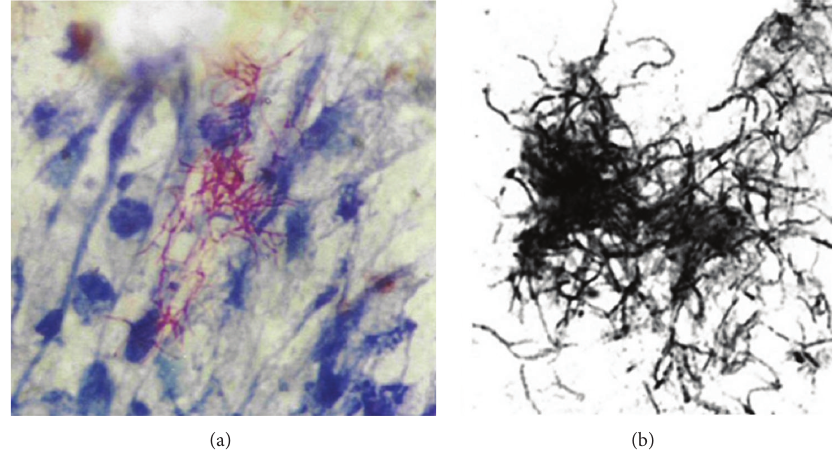
Figure 3: Smears made from a purulent material of M. farcinogenes -infected cow (a) showing acid fast branching filaments and smear made from a culture of M. senegalense (b). Note short or long filaments, bent and branched, in clumps or tangled lacy network which do not fragment into bacillary forms.